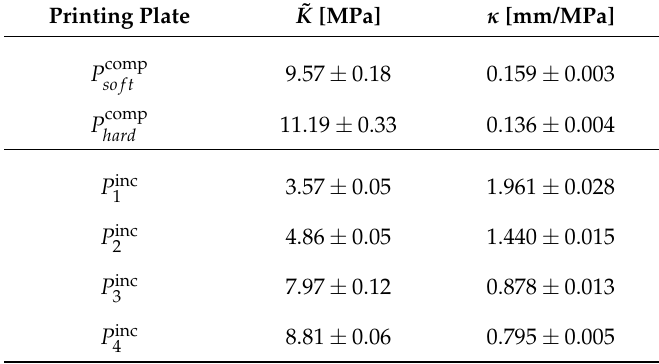
( P comp ) and incompressible ( P inc ) printing